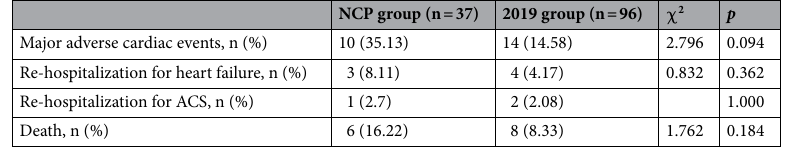
Table 2. Major adverse cardiac events in 3-month follow-up.